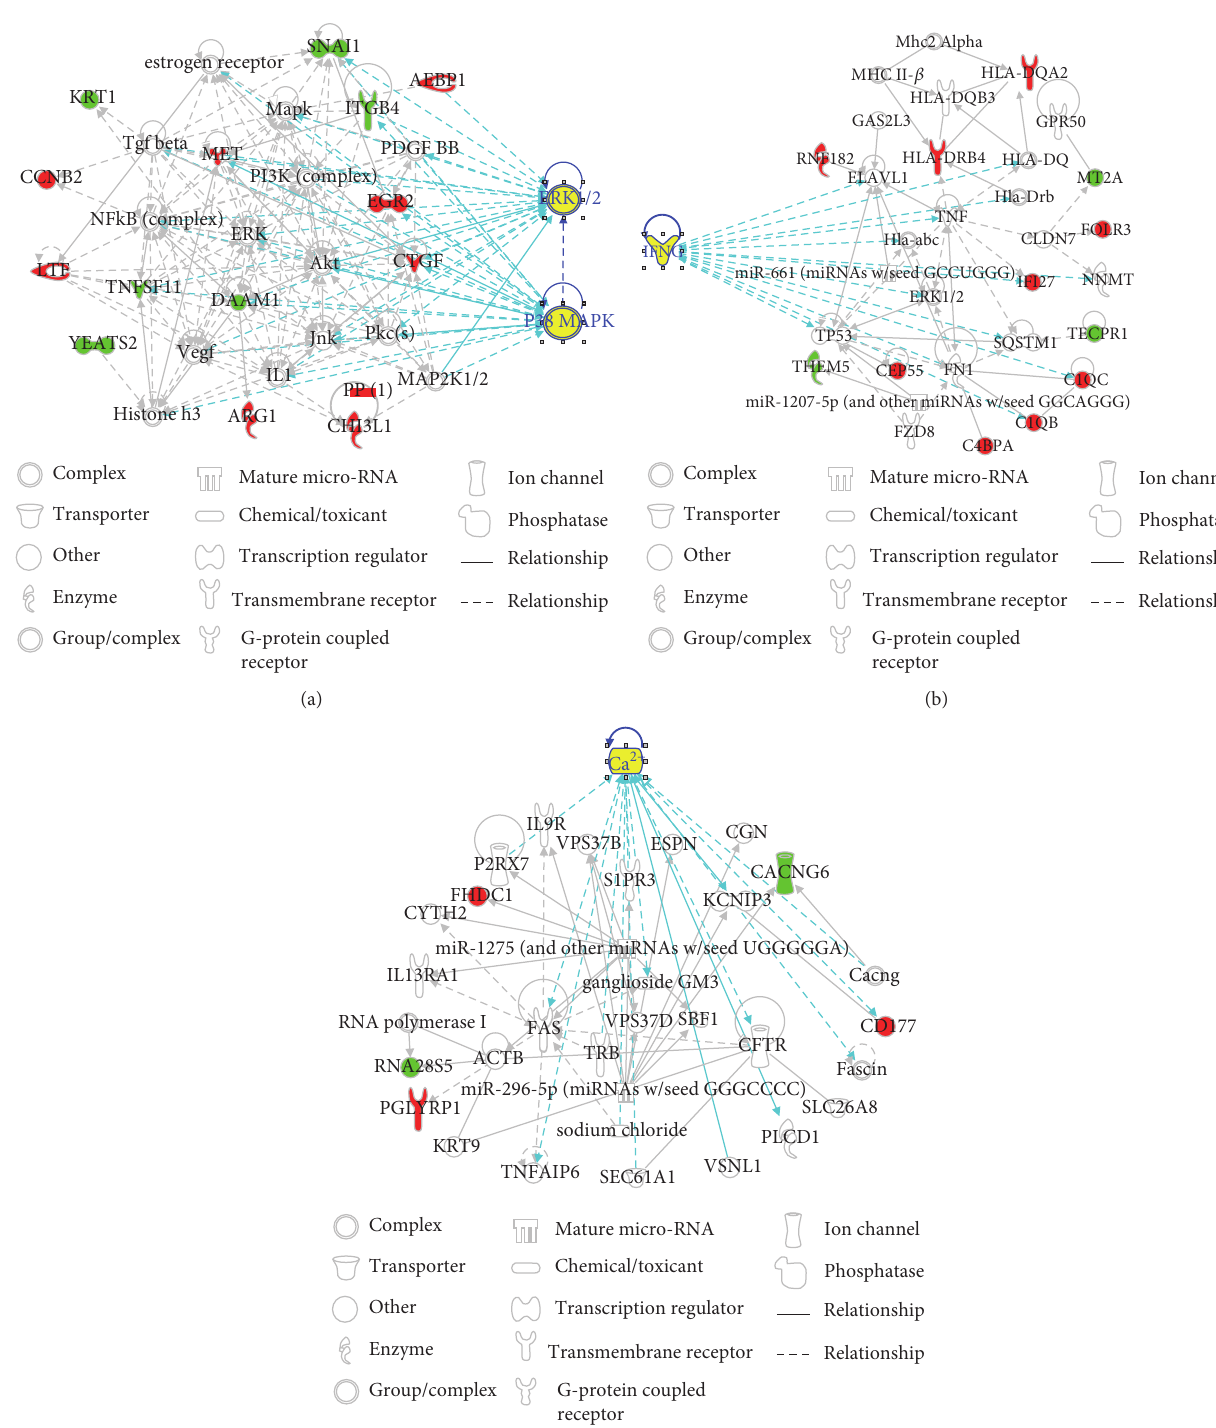
Figure 3: Biomolecular networks related to the shared DEGs. In each network, molecules are represented as nodes, and the biological relationship between two nodes is represented as a line. Red symbols represent upregulated DEGs; green symbols represent downregulated DEGs. Yellow symbols indicate the highly linked molecules from the Ingenuity Knowledge Database. Solid lines between molecules indicate a direct physical relationship between molecules, whereas dash lines represent indirect functional relationships. (a) The first network. (b) The second network. (c) The third